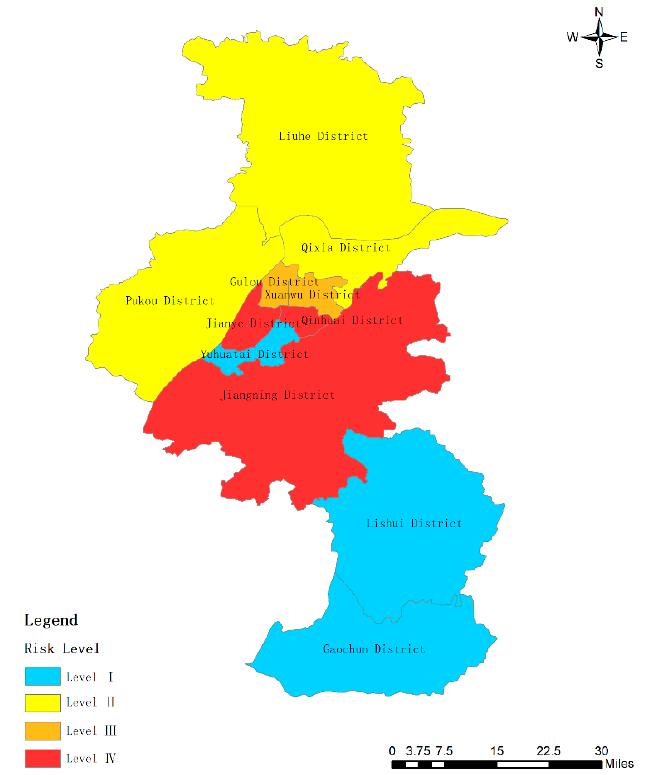
Figure 4. Risk level of subsystem Y 22 in Nanjing.